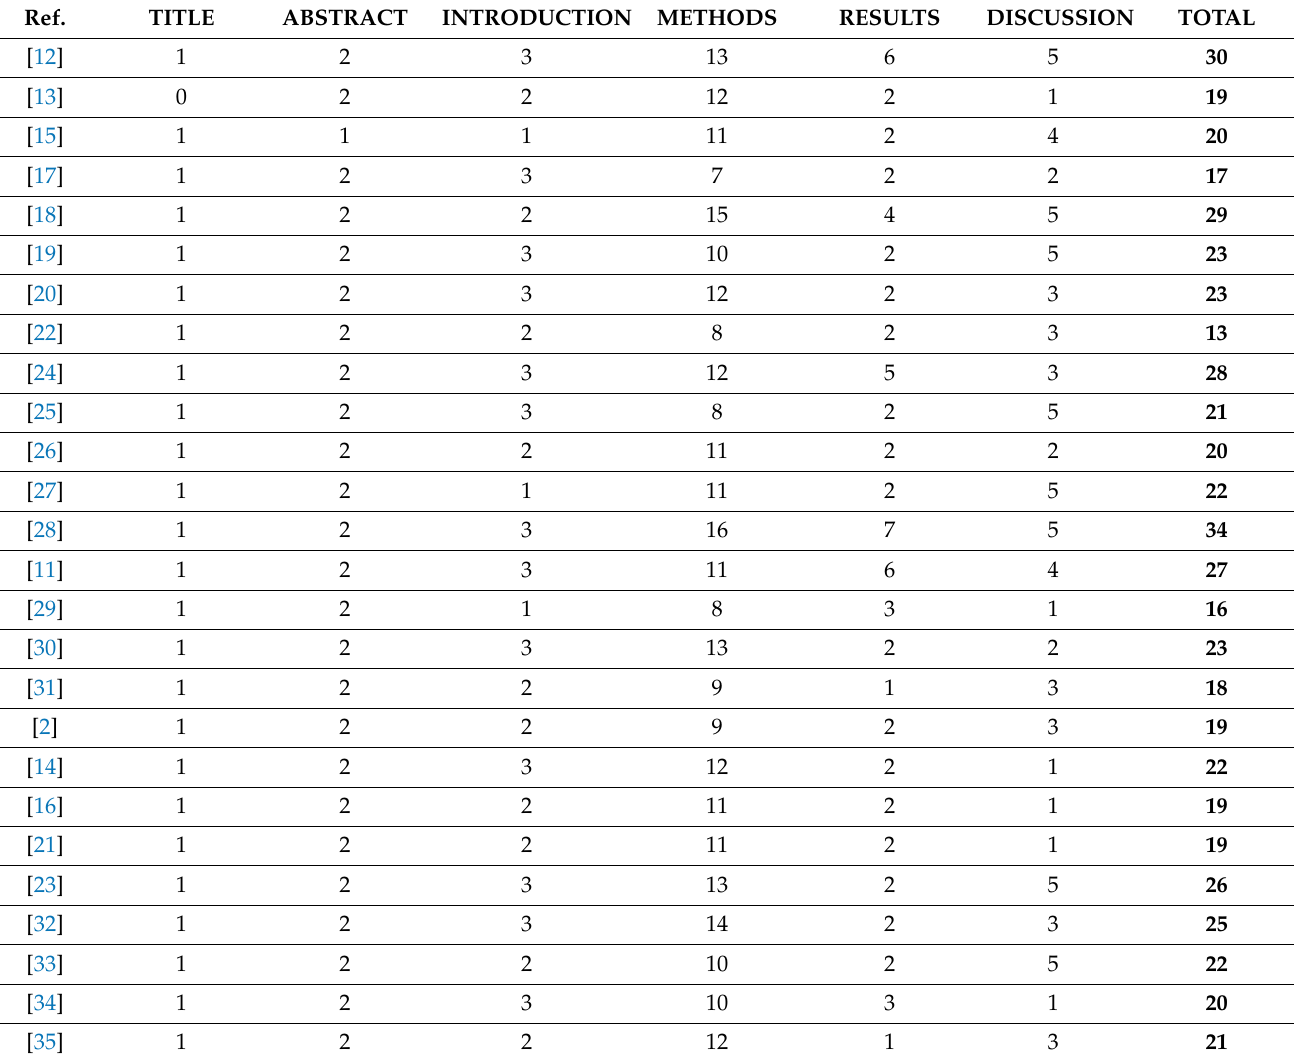
Table 4. Quality assessment of in vivo studies.